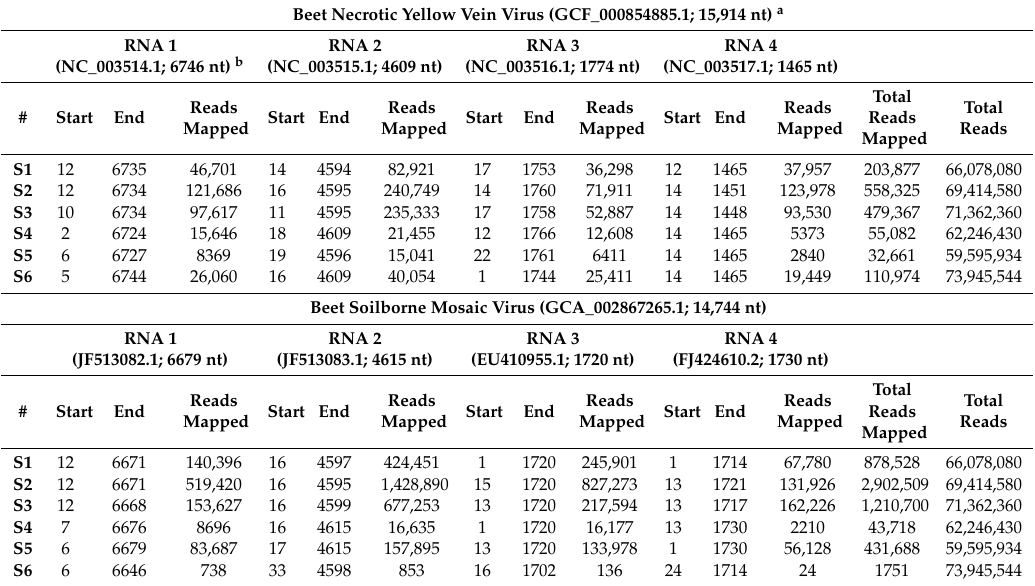
Table 1. RNAseq reads mapped to known sugar beet